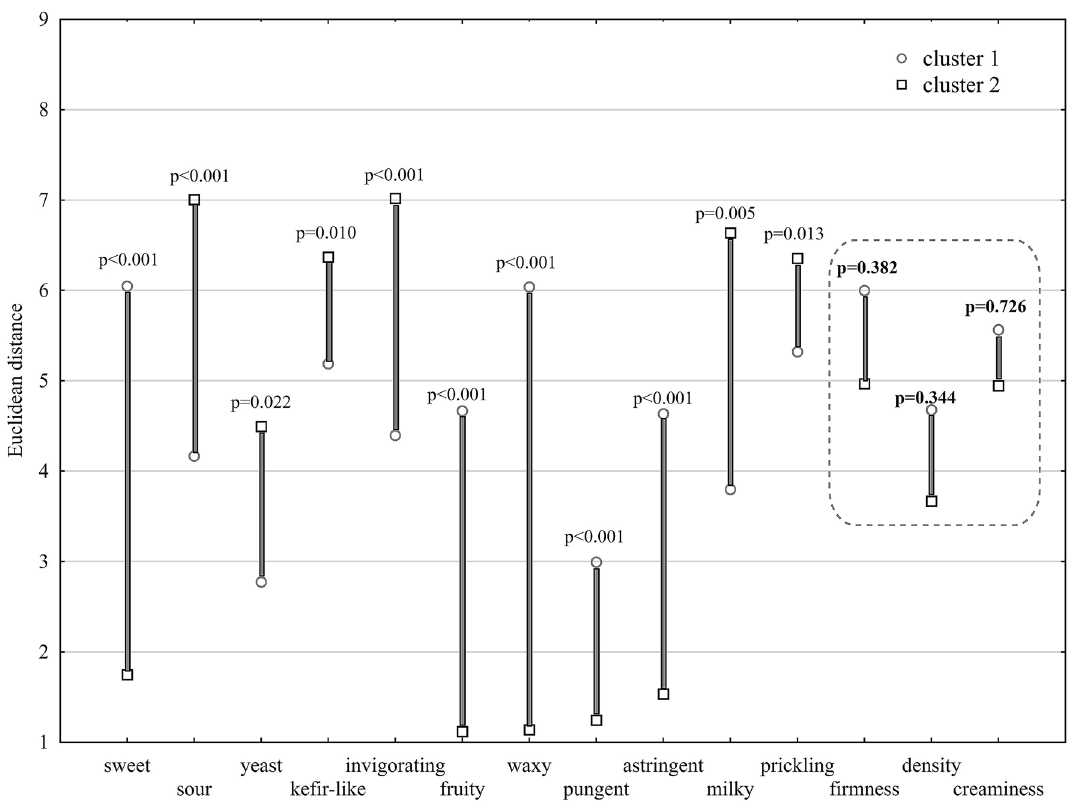
Figure 1. Grouping by the k-means of sensory profiling of kefir with the addition of honey in different amounts and storage times.